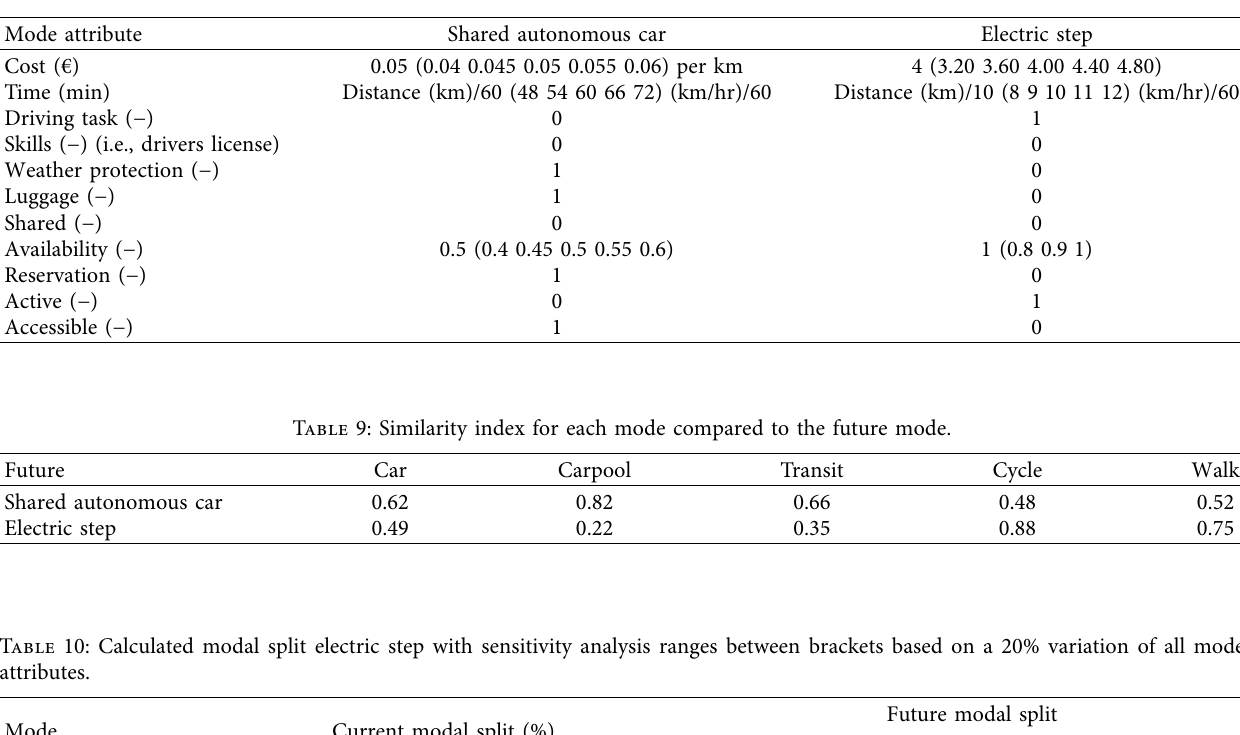
Table 8: Attributes shared by autonomous cars and electric steps are listed with sensitivity analysis values between square brackets based on a 20% variation of all mode attributes.